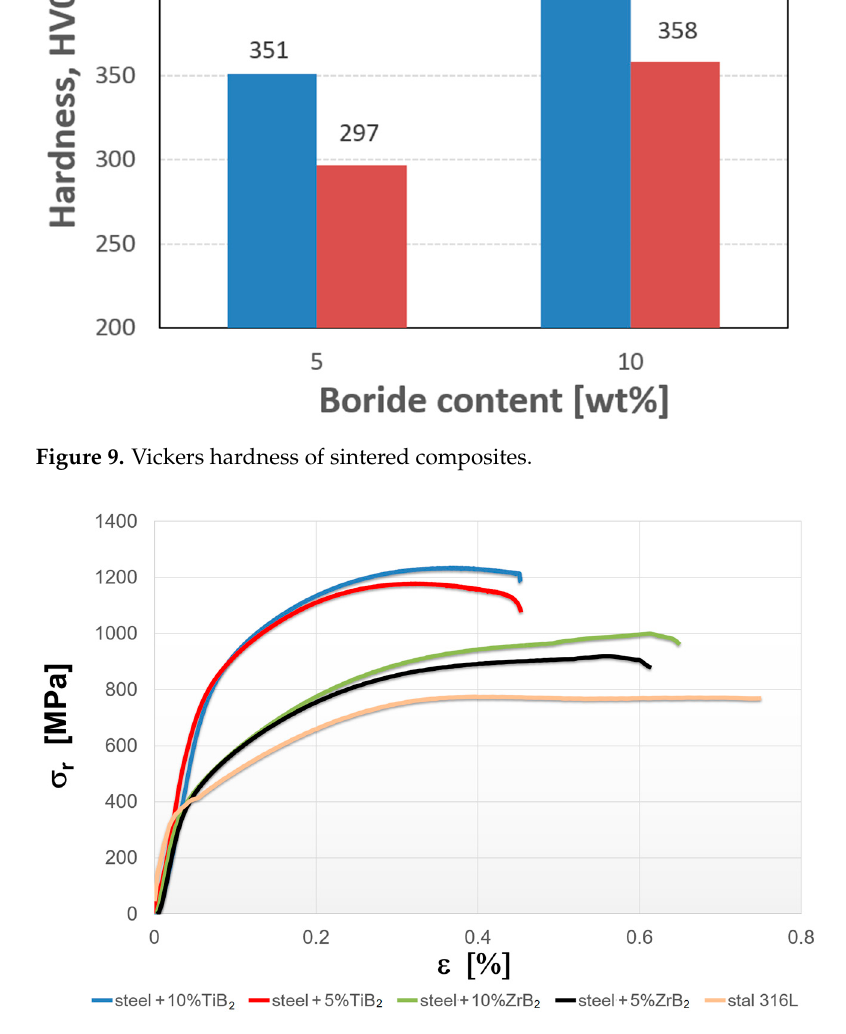
Figure 10. Compressive stress–strain curves for sintered materials.